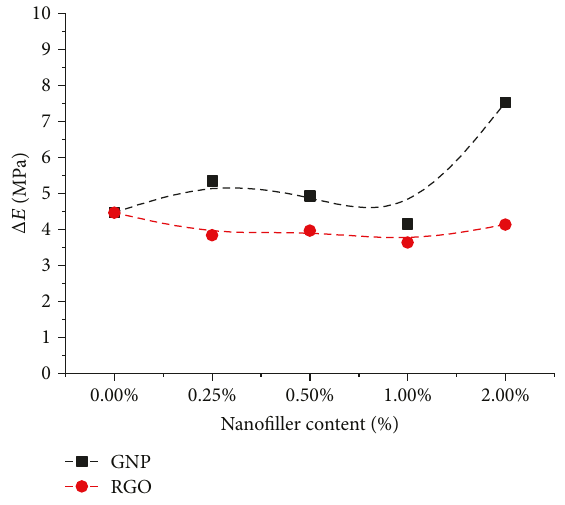
Figure 17: Payne e ff ect improvement Δ E for PU20